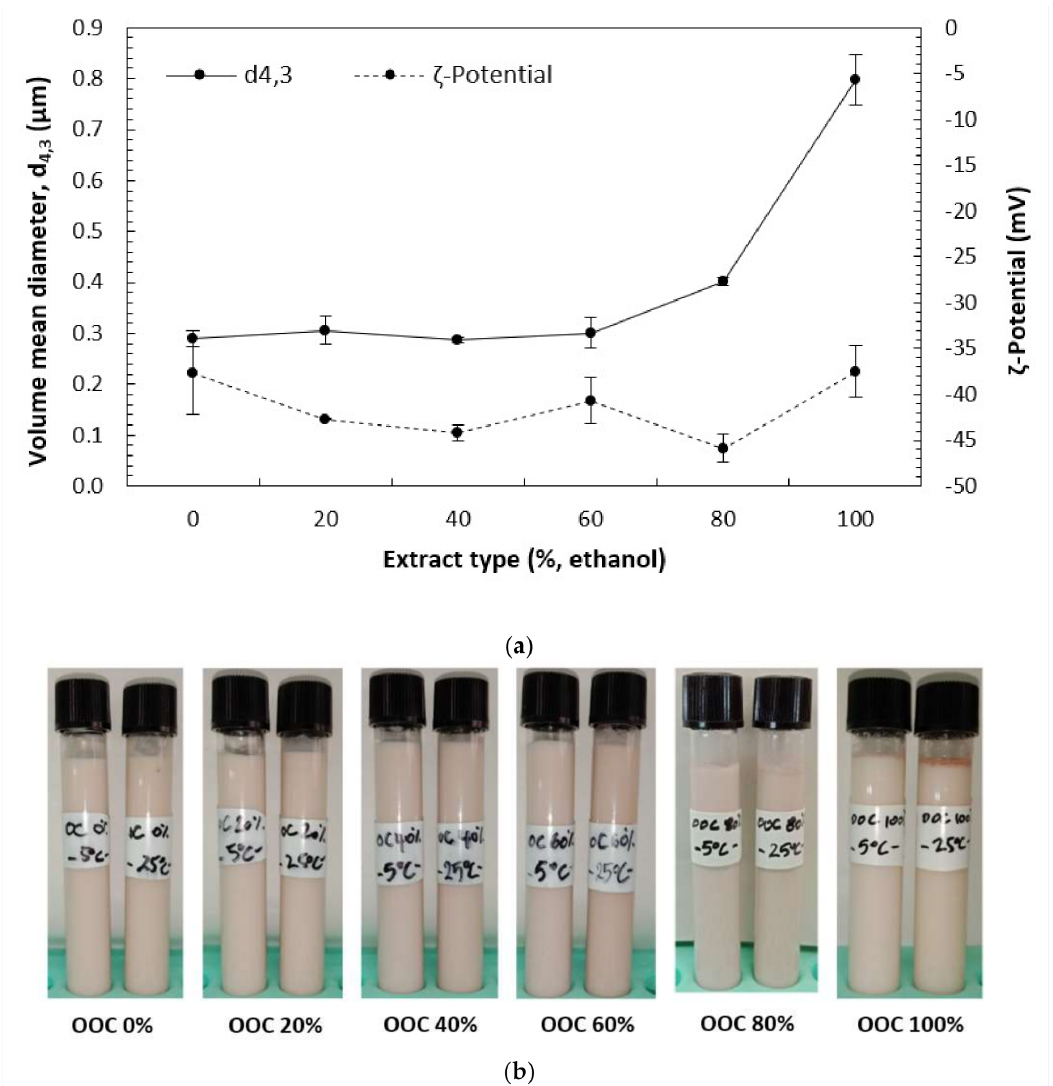
Figure 3. ( a ) Volume mean droplet diameter ( d 4,3 ) and ζ -potential of soybean oil-in-water (O/W) emulsions prepared using OOC aqueous ethanolic extracts, by high-pressure homogenization (100 MPa, 4 passes). ( b ) Visual appearance of OOC extract-stabilized emulsions after 15 days of storage at 5 ◦ C or 25 ◦